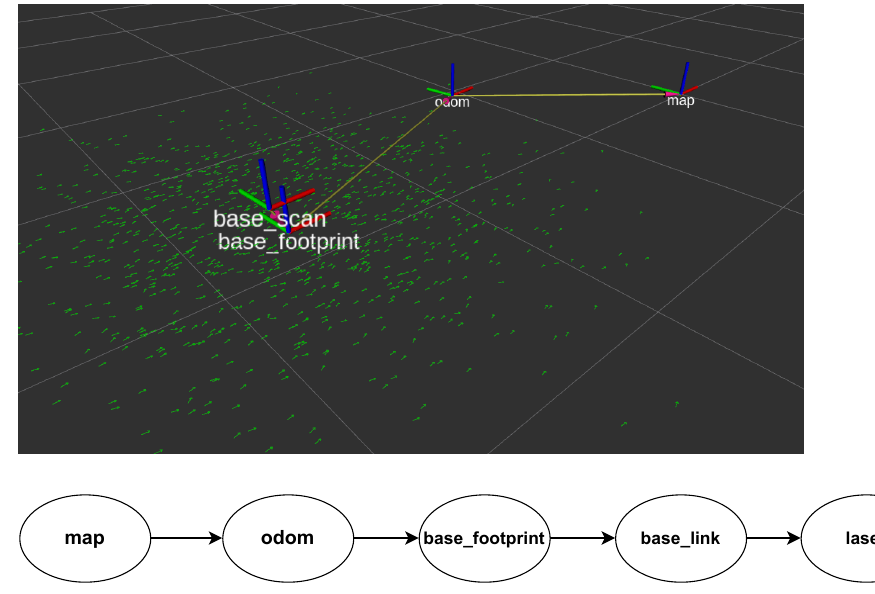
Figure 6. Coordinate axes connections from the map frame to the sensor